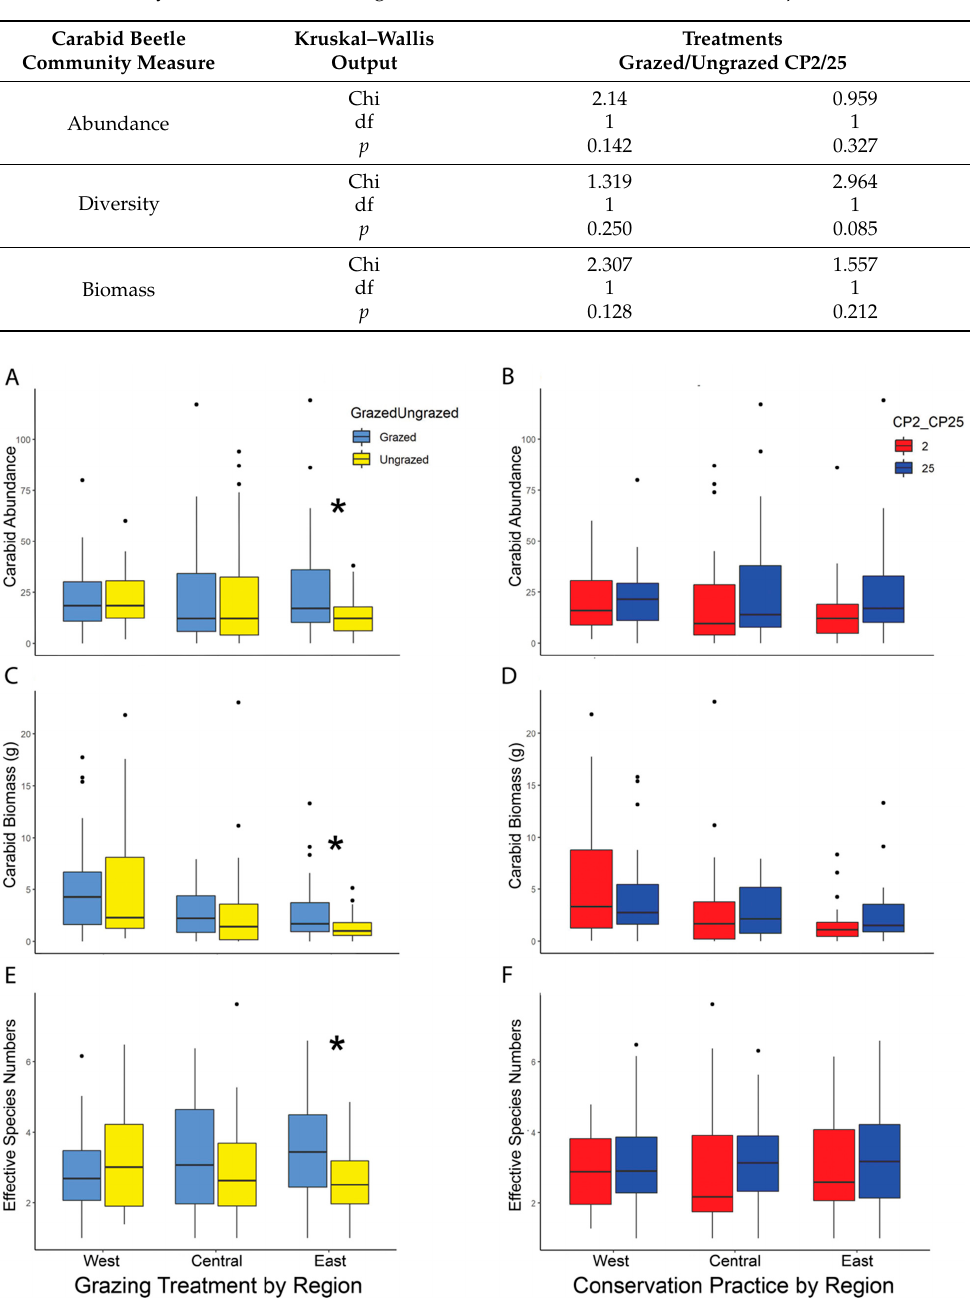
Figure 3. ( A )–( F ): Boxplots showing the median carabid abundance, biomass, and diversity by study region (West, Central, East) and treatment (grazed vs. ungrazed, and CP2 vs. CP25). There was no effect of restoration type (CP2 vs. CP25) on these three carabid measures ( B , D , F ). There was a significant positive effect of grazing on carabid abundance (( A ), p = 0.033), biomass (( C ), p = 0.033), and diversity (( E ), p = 0.010) in the East study region. Boxes represent the middle 50th percentile of data while each whisker represents an additional 25th percentile. The dots represent data points more than 1.5 times outside of the interquartile range. Asterisks used to denote significant p -values from Kruskal–Wallis tests ( p ≤ 0.05). Figures for data adjusted for trap days can be found in the supplemental documents (Figure S4).